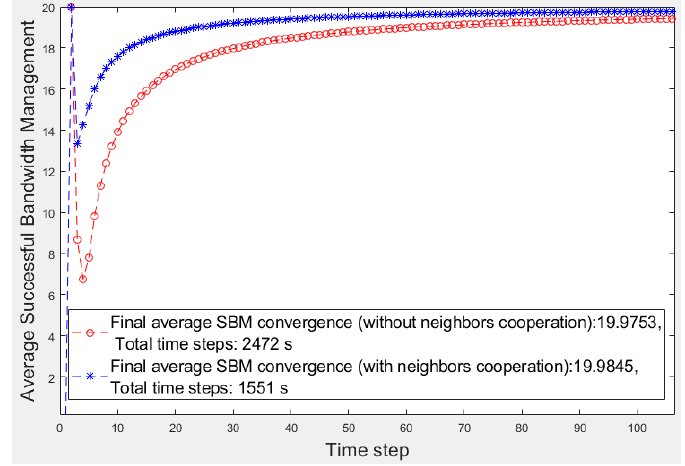
Figure 4. First 100 s of Figure 3.